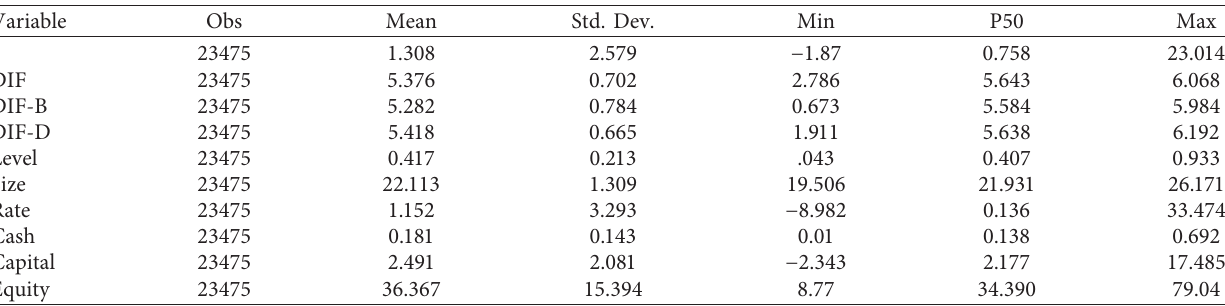
Table 2: Descriptive